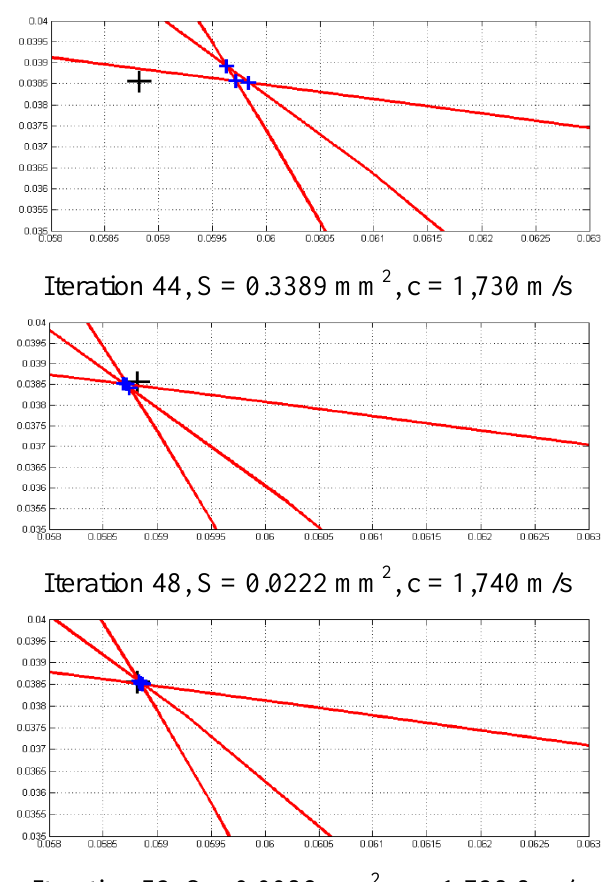
(distance units in Im